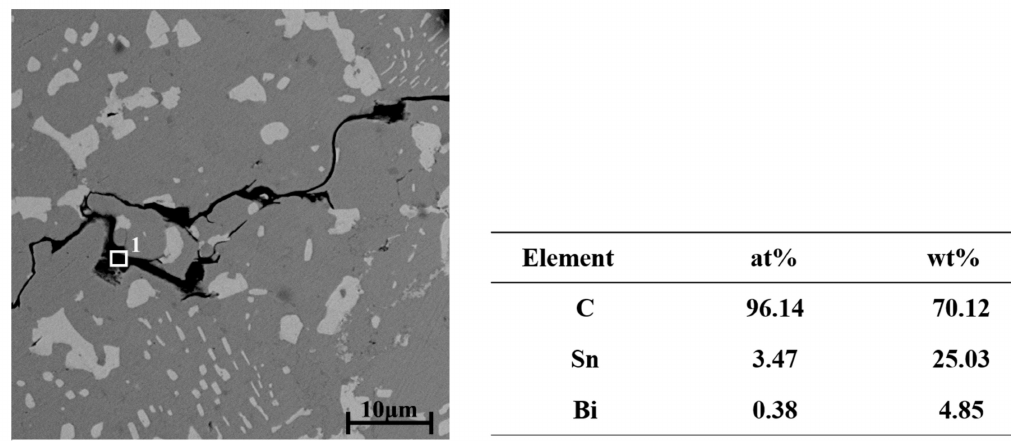
Figure 5. The energy spectrum analysis in